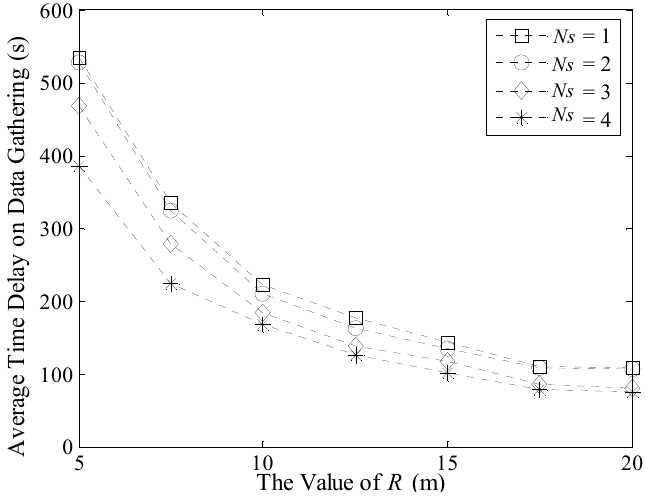
Figure 23. Average time delay on data gathering (200 m × 200 m, 500 nodes).